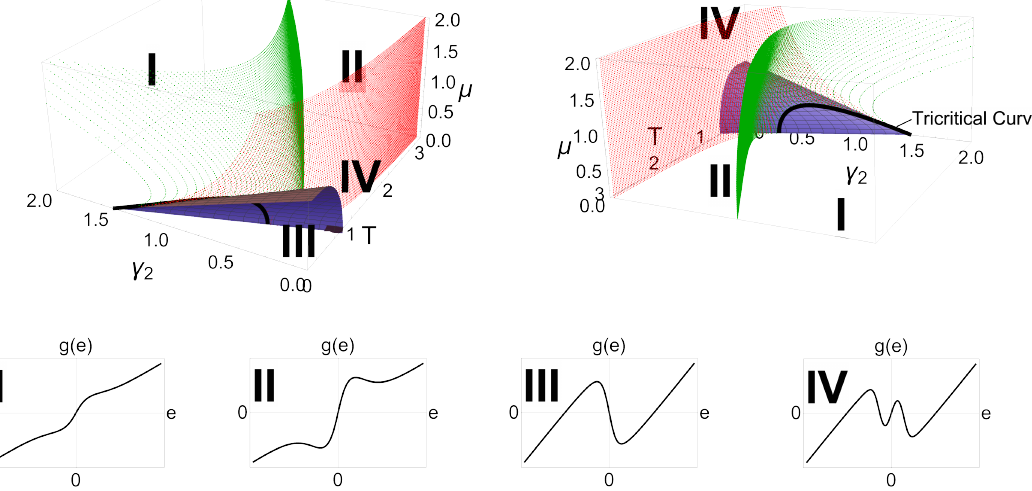
Figure 16 . Three-dimensional phase diagram of g ( e ) in the ( γ 2 , µ, T ) space. The insets show the possible shapes of the derivative of the potential g ( e ) , see (6.3), at finite chemical potential and